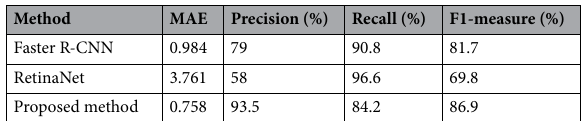
Table 4. Comparative results between our method and Faster R-CNN and RetinaNet.